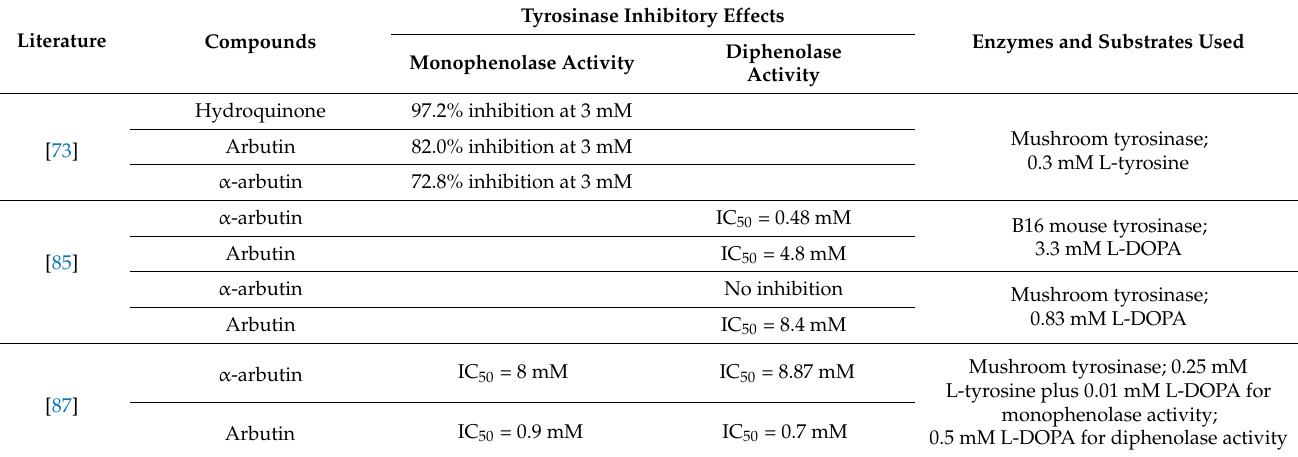
Table 1. Tyrosinase inhibitory effects of arbutin and α